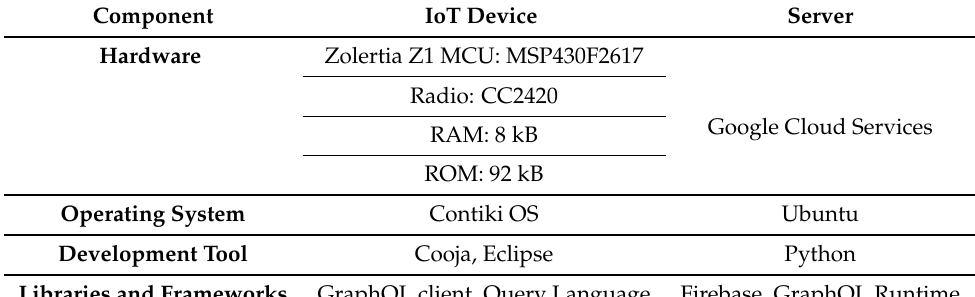
Table 2. Configuration details of Server and IoT devices used in experimental setup.